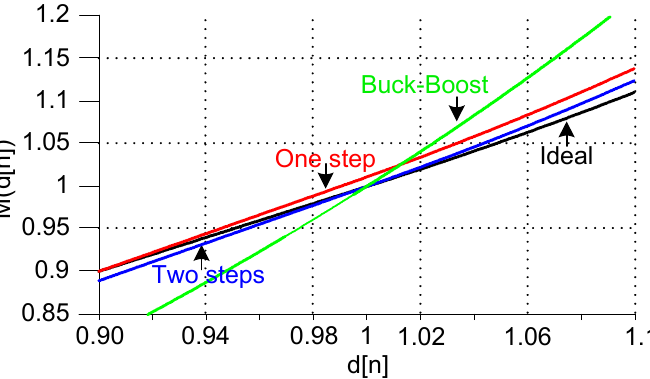
Figure 13. Conversion ratio M(d[n]) in function of d[n] using different implementations in comparison with the ideal.